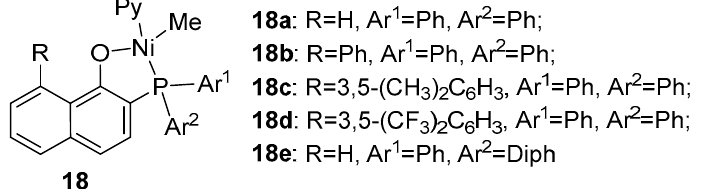
Figure 15. Super-robust methyl nickel catalysts 18a – e with phosphino-naphtholate chelate ligands.